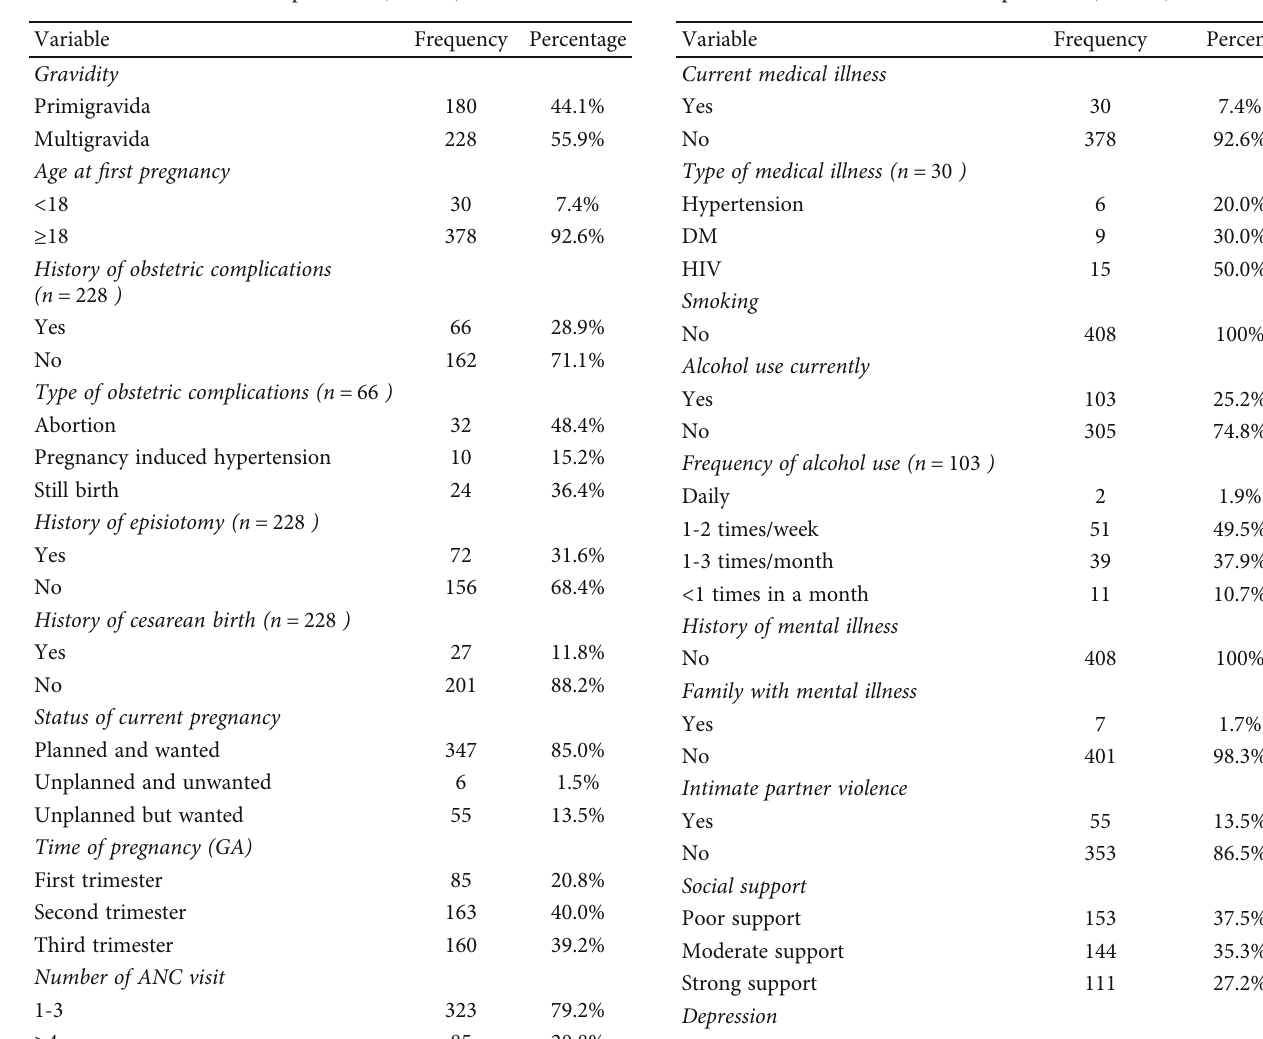
Table 2: Obstetrical and gynecologic characteristics of women attending antenatal care at Debre Markos town public health institutions, Northwest Ethiopia, 2021 ( n = 408 ).